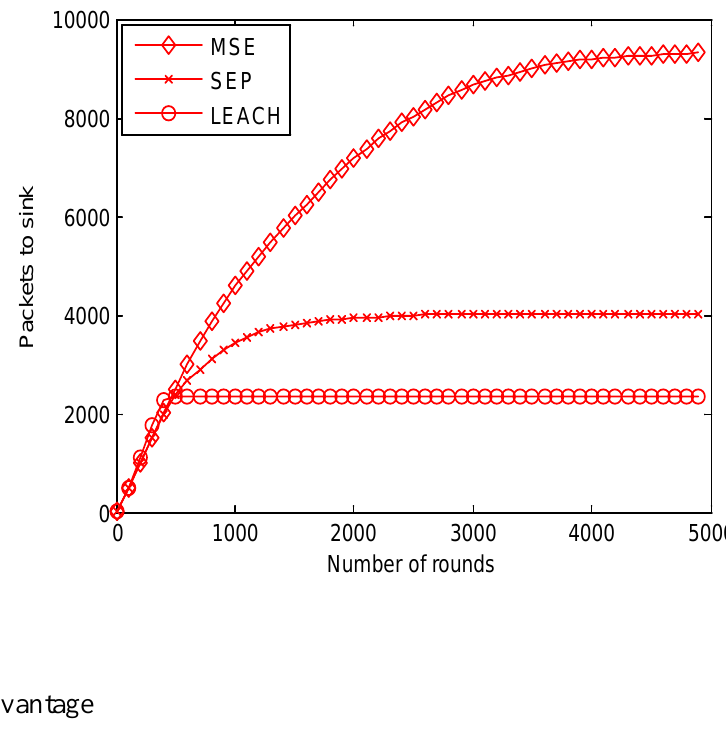
Figure 11. Packets received by the sink